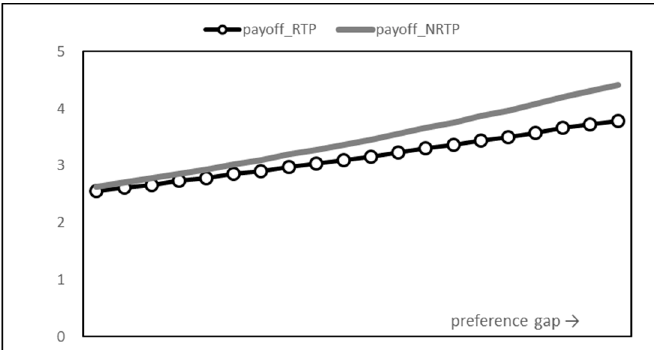
Figure 11. User payoff graph.